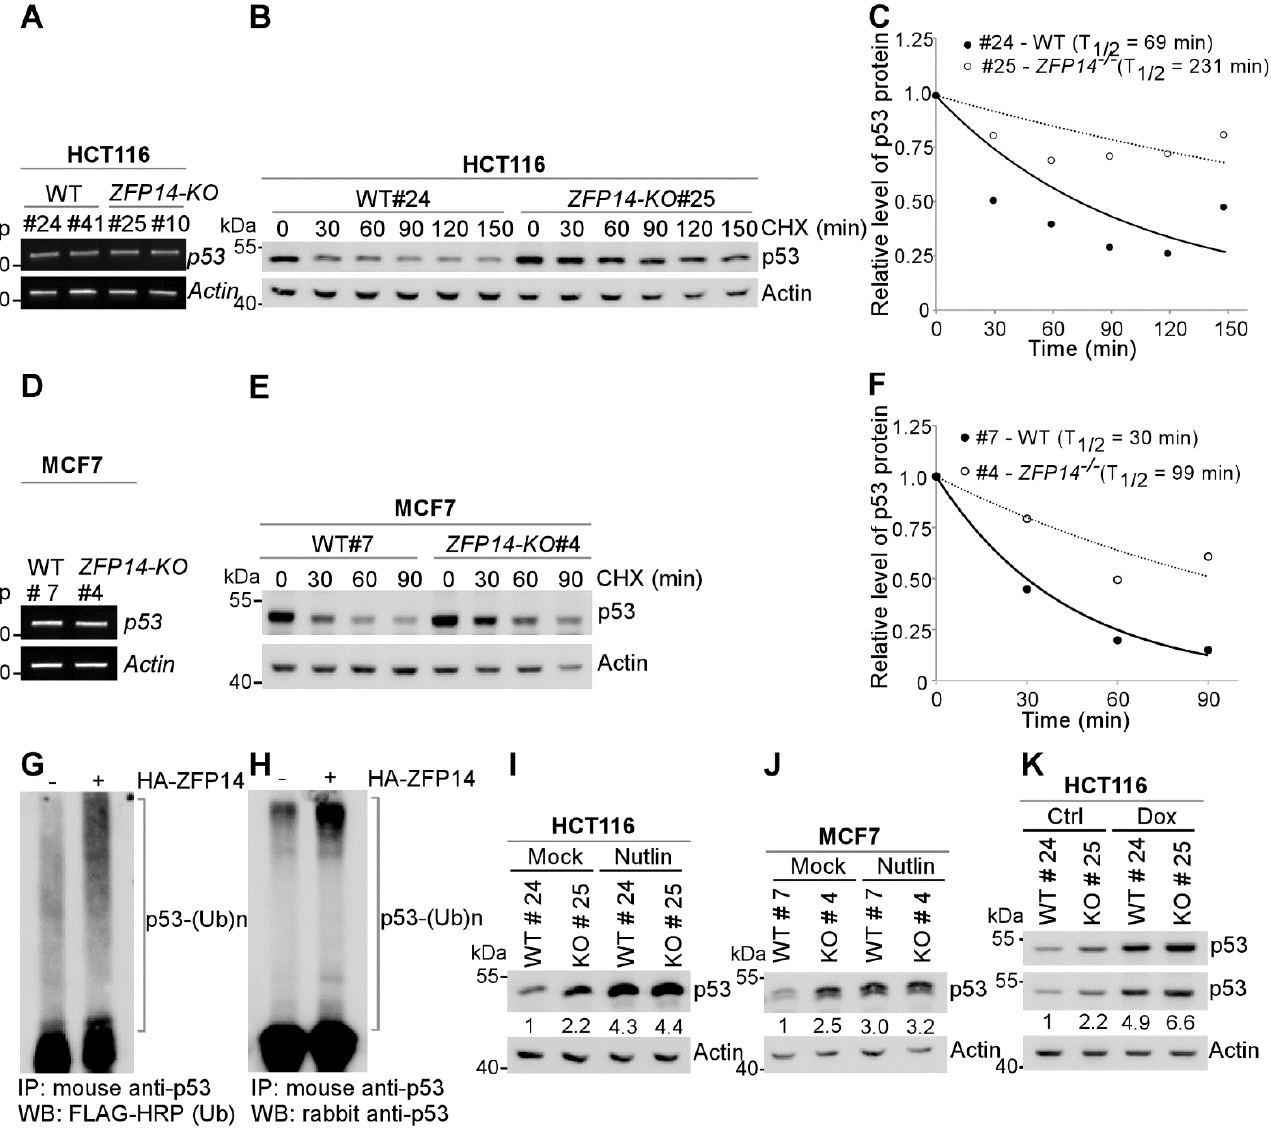
Figure 3. ZFP14 regulates p53 protein stability through MDM2. ( A , D ) The levels of p53 and actin mRNAs were measured in isogenic controls and ZFP14 ‐ KO HCT116 (clones #25 and #10) cells ( A ) or isogenic control and ZFP14 ‐ KO MCF7 (clone #4) cells ( D ). ( B , E ) The levels of p53, vinculin and actin proteins were measured in isogenic control and ZFP14 ‐ KO HCT116 (clone# 25) cells ( B ) or isogenic control and ZFP14 ‐ KO MCF7 (clone #4) cells ( E ) mock ‐ treated or treated with cyclo ‐ heximide (CHX) for indicated times. ( C , F ) The relative level of p53 protein in ( B , E ) was normalized to actin and the half ‐ life of p53 protein was calculated by plotting the remaining protein over time. ( G , H ) pcDNA3 ‐ p53 and pcDNA3 ‐ 2× ‐ Flag ‐ ubiquitin with or without pcDNA3 ‐ HA ‐ ZFP14 were transfected in HCT116 cells followed by treatment with 20 μ M MG132 for 5 h. Poly ‐ ubiquitinated p53 levels in whole ‐ cell lysates were measured by immunoprecipitation with mouse anti ‐ p53 anti ‐ body followed by Western blotting with FLAG ‐ HRP ( G ) or rabbit anti ‐ p53 (H). ( I , J ) The levels of p53 and actin proteins were measured in isogenic control and ZFP14 ‐ KO HCT116 (clone# 25) cells ( I ) or isogenic control and ZFP14 ‐ KO MCF7 (clone #4) cells ( J ) mock ‐ treated or treated with Nutlin for 16 h. ( K ) The levels of p53 and actin proteins were measured in isogenic control and ZFP14 ‐ KO HCT116 (clone# 25) cells mock ‐ treated or treated with 250 μ g/mL Dox for 18 h. As ubiquitination is a major mechanism by which p53 protein stability is regulated, we next investigated whether ZFP14 promotes p53 ubiquitination, resulting in enhanced p53 degradation. For this, we co ‐ expressed p53 and 2× ‐ FLAG ‐ ubiquitin with or without